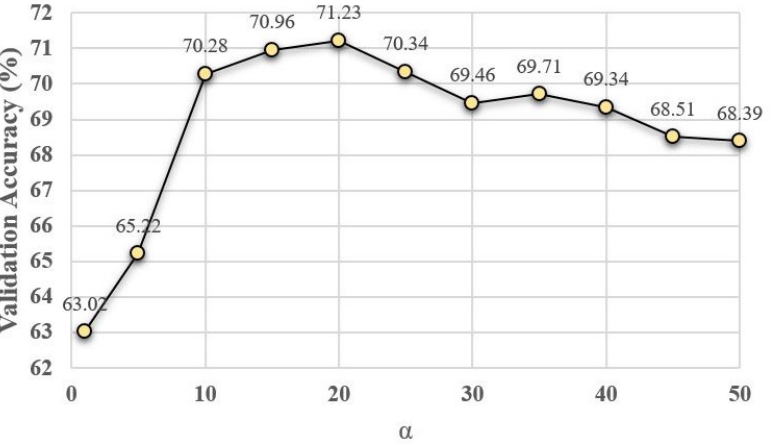
Figure 5. Validation accuracy of DPP dropout model with different configurations of defined hyper- parameter α in (19) on the CIFAR10 dataset.